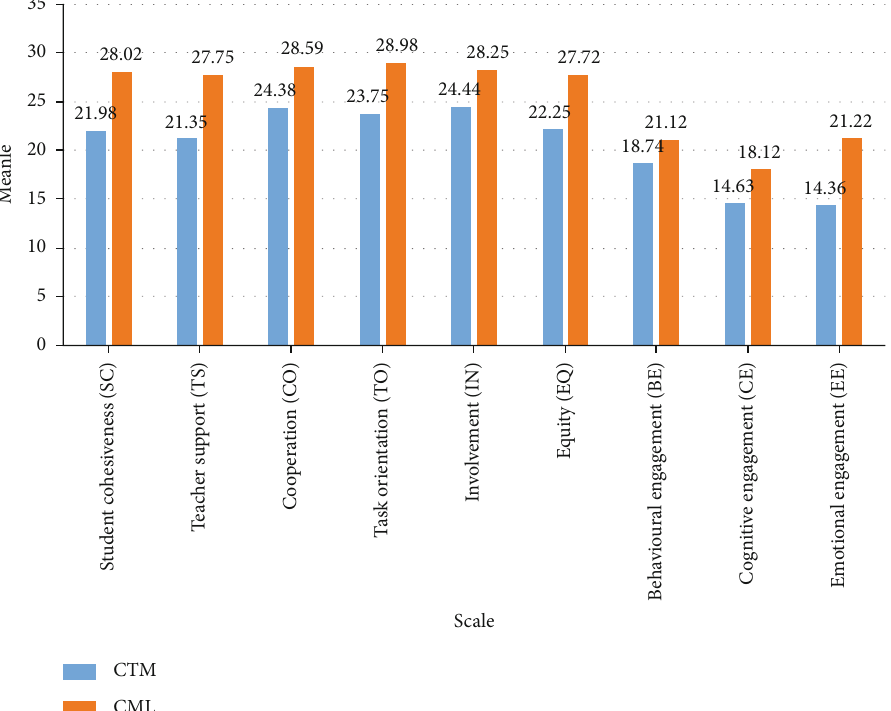
Figure 2: Mean scores for students who were taught using CML and those taught using CTM for the scales of the WIHIC and SE ( N = 298 ). Table 4: Mean, standard deviation, and sex di ff erence for students taught using the CML for each classroom learning environment and engagement scales. Sex Di ff erence between male and female classesMale students in CML